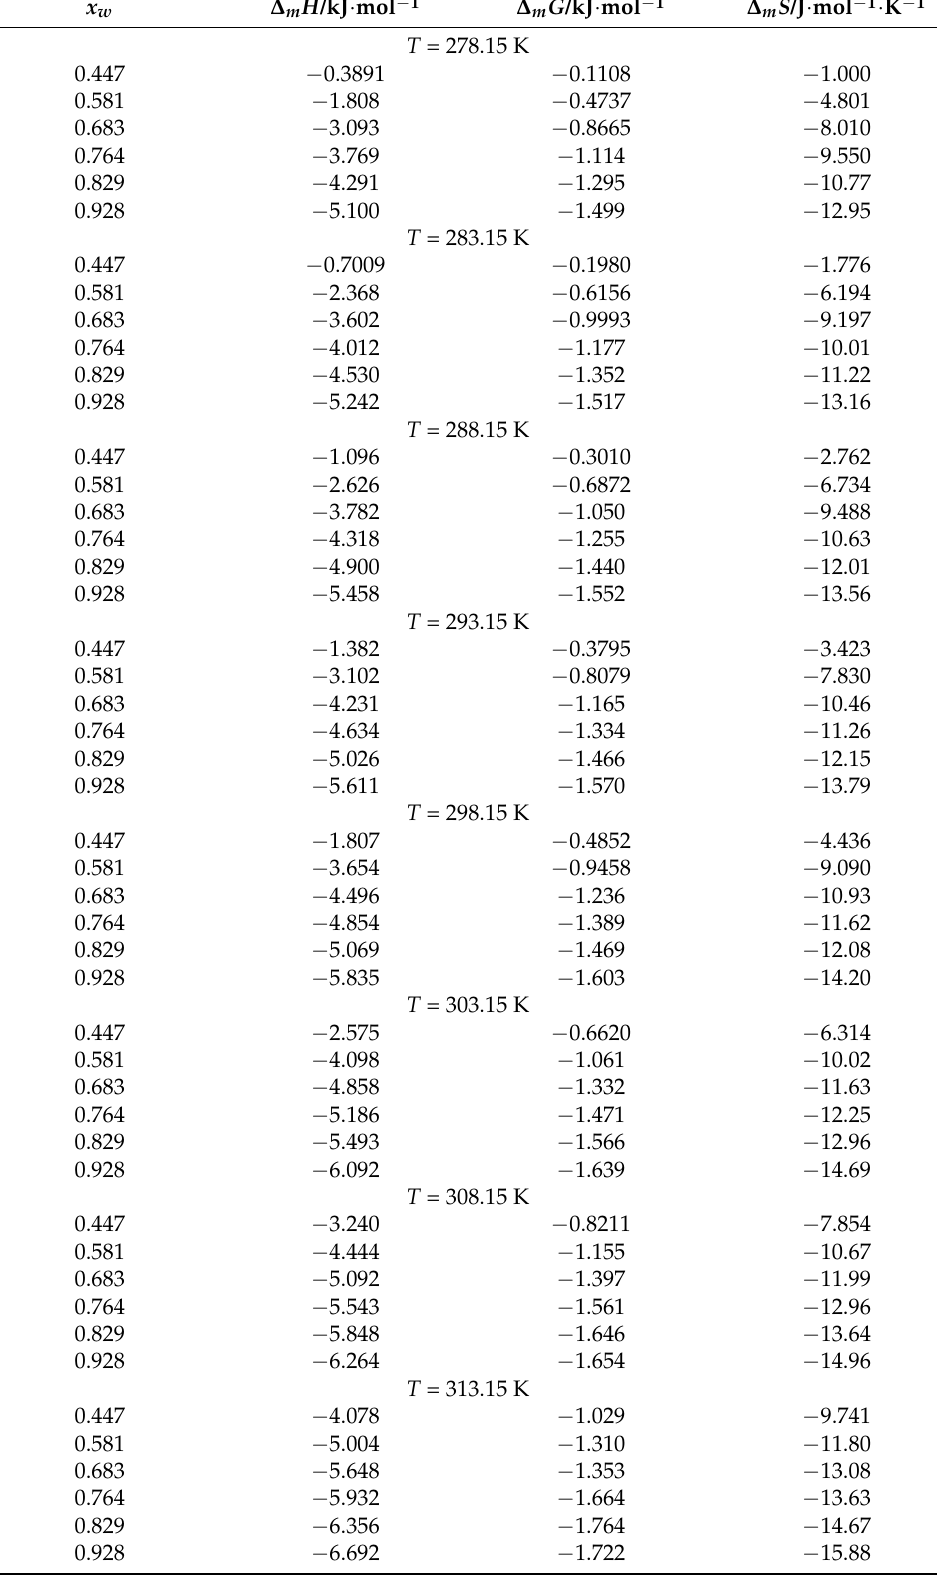
Table 11. Mixing thermodynamic properties of 1,5-pentanediamine adipate dihydrate in water + ethanol mixtures a,b